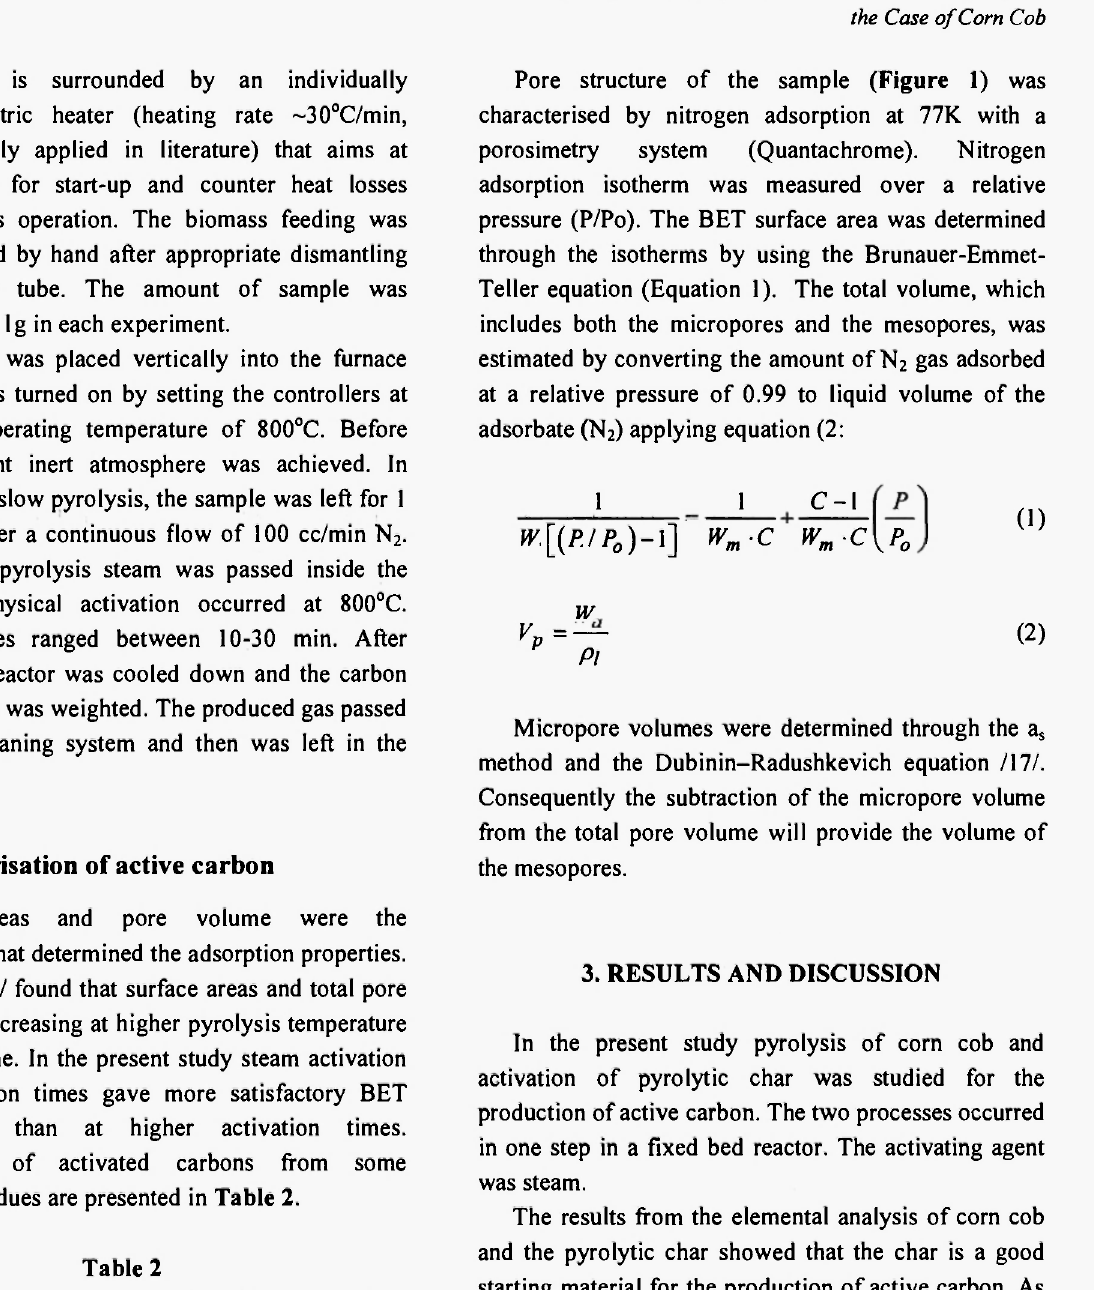
Characteristics of activated carbon from corn cob (literature